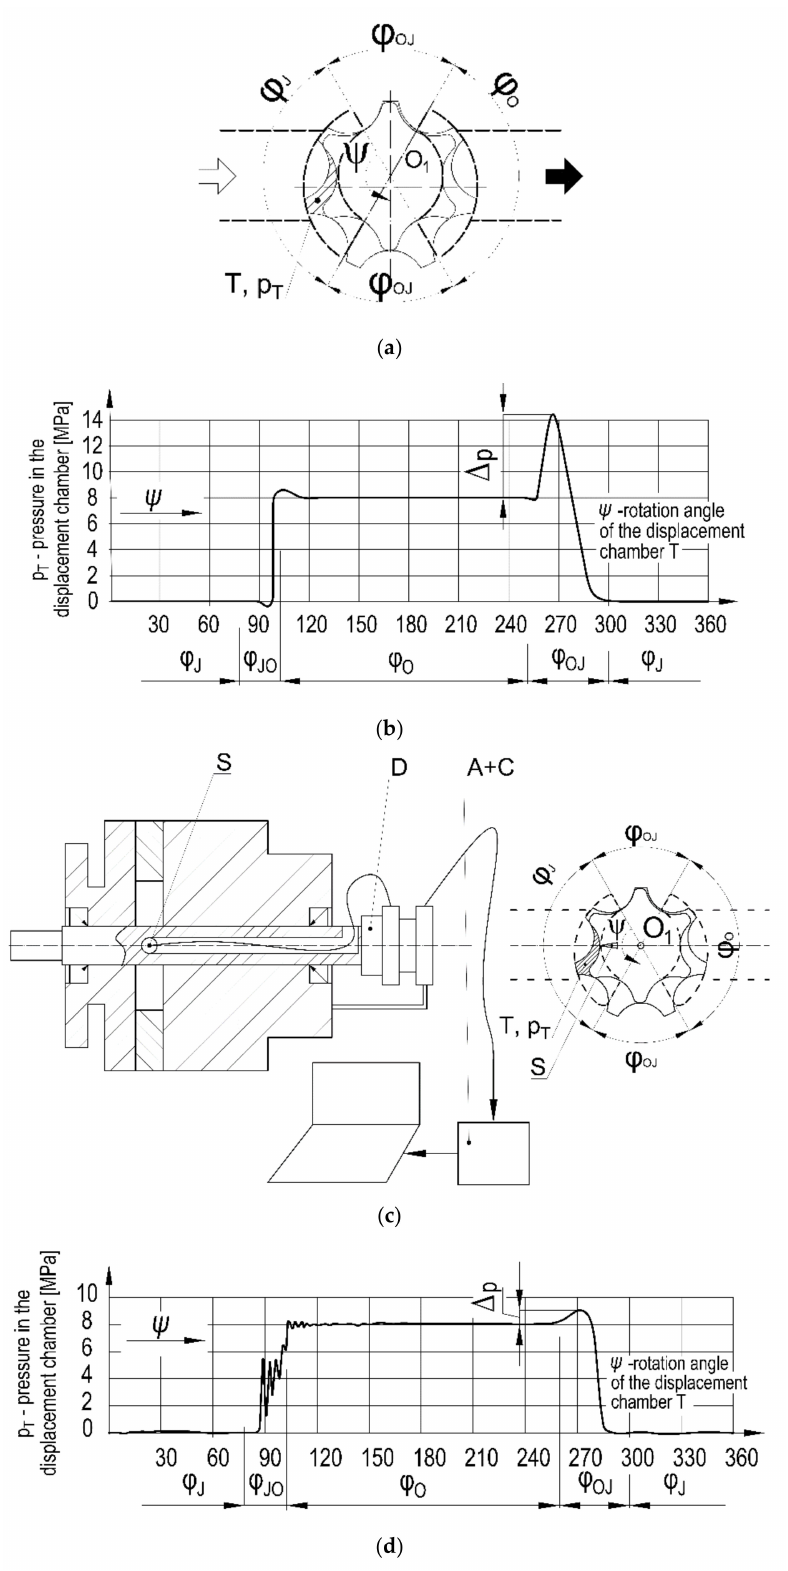
Figure 17. Research of pressure p T in the displacement chamber T of the gerotor pump during the full working cycle: ( a ) division into the internal working zones ϕ J , ϕ JO , ϕ O , ϕ OJ ; ( b ) results of pressure simulation p T = f( ψ ) ; ( c ) view of the experimental gerotor pump ( S —pressure sensor; D —device; A —amplifier; C —computer); ( d ) results of the experimental pressure research p T = f( ψ